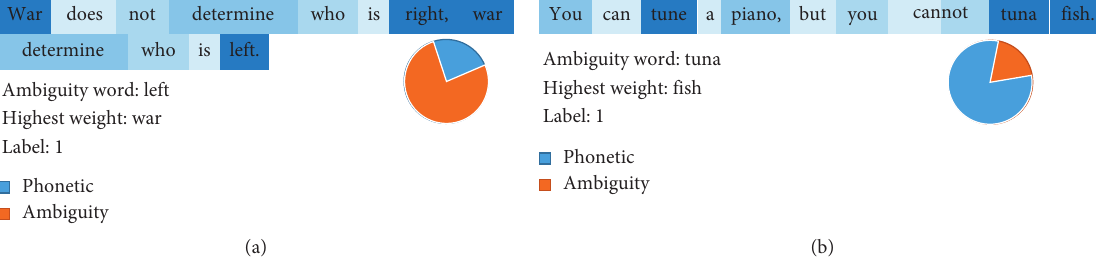
Figure 2: Visualization of attention. A darker color means more importance. The pie chart shows the weights of the two parts based on gated attention